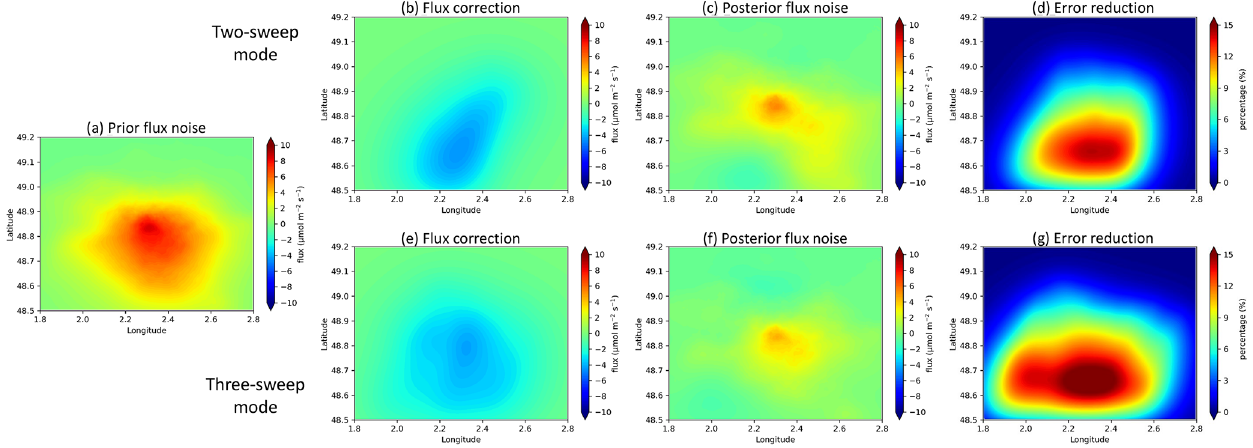
Figure A6. Prior flux noise (prior state minus truth), flux correction (posterior minus prior state), posterior flux noise (posterior state minus truth), and flux error reduction using the cloud-free samplings of the two-sweep (b–d) and three-sweep (e–g) modes in Paris (considering only anthropogenic emissions.).